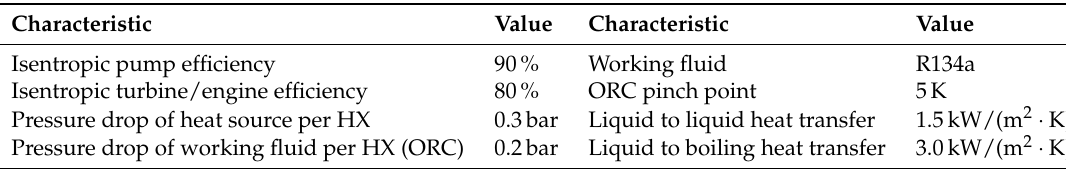
Table 2. Reference parameters of the cycle